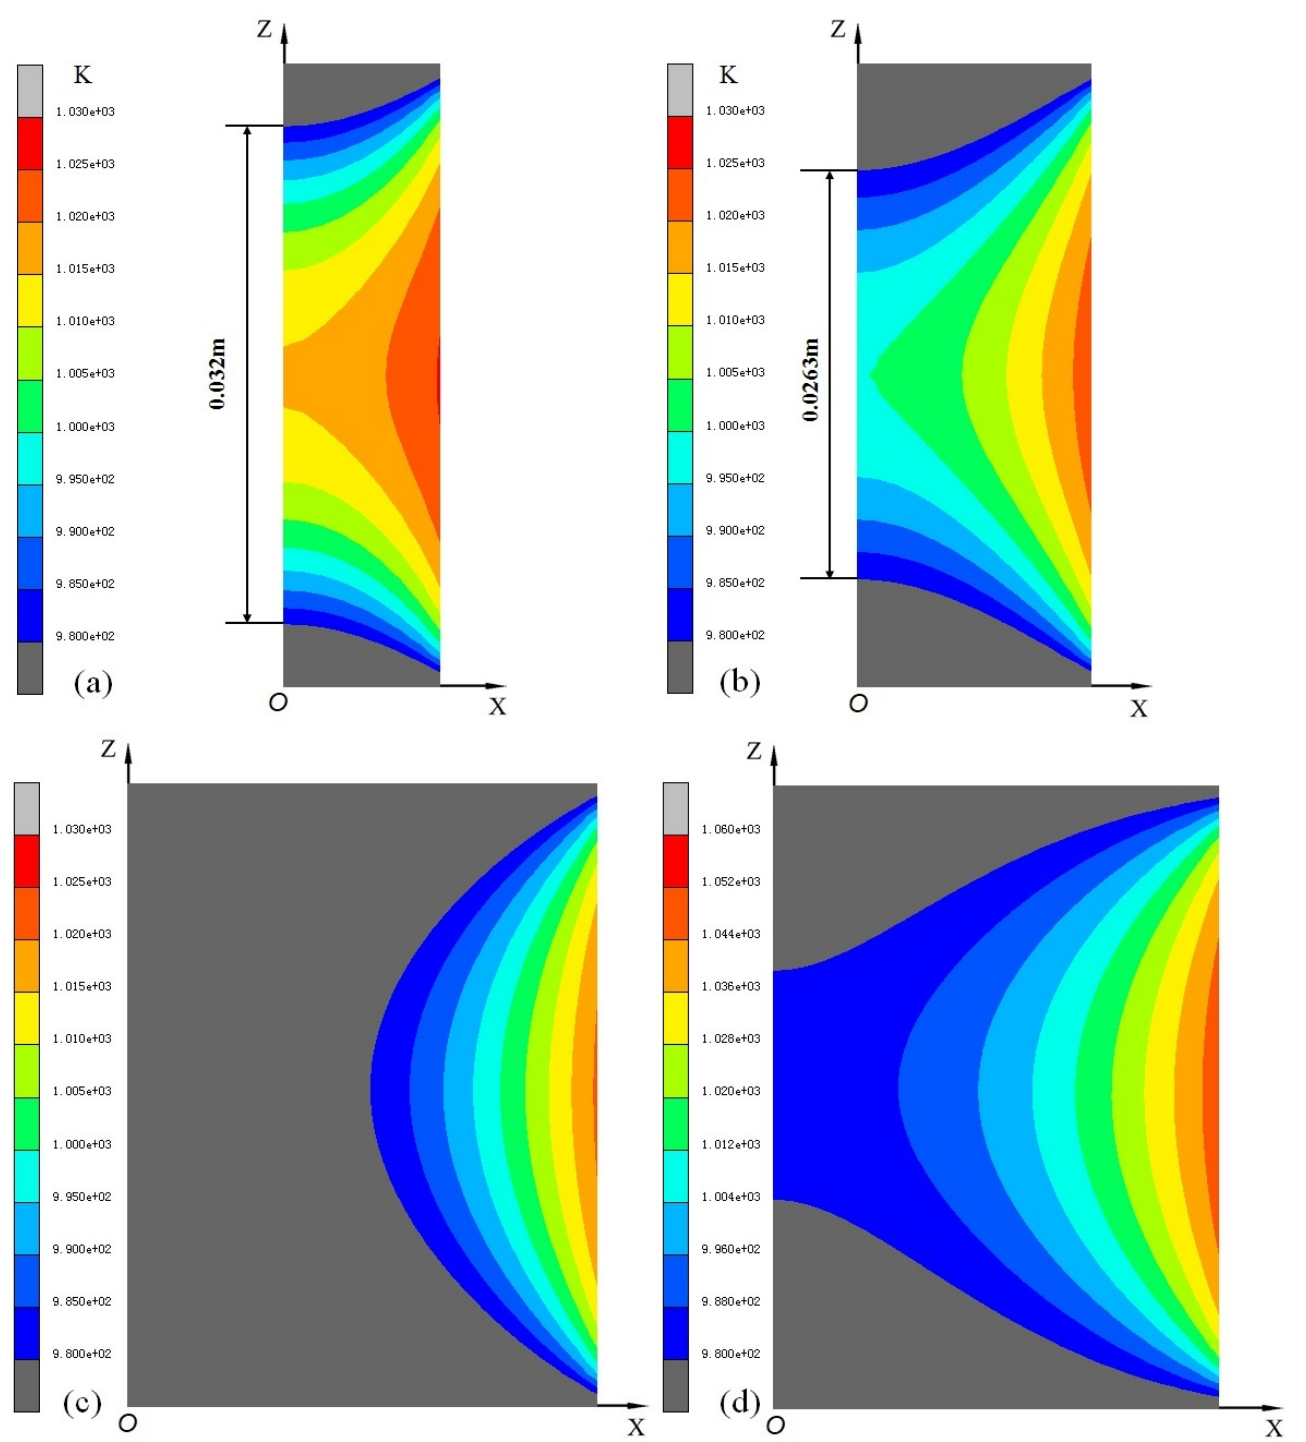
Figure 2. The temperature filed at the initial stage of crystal growth: ( a ) the crystal radius is 0.01 m and the maximum furnace temperature is 1030 K; ( b ) the crystal radius is 0.02 m and the maximum furnace temperature is 1030 K; ( c ) the crystal radius is 0.03 m and the maximum furnace temperature is 1030 K; ( d ) the crystal radius is 0.03 m and the maximum furnace temperature is 1060 K.